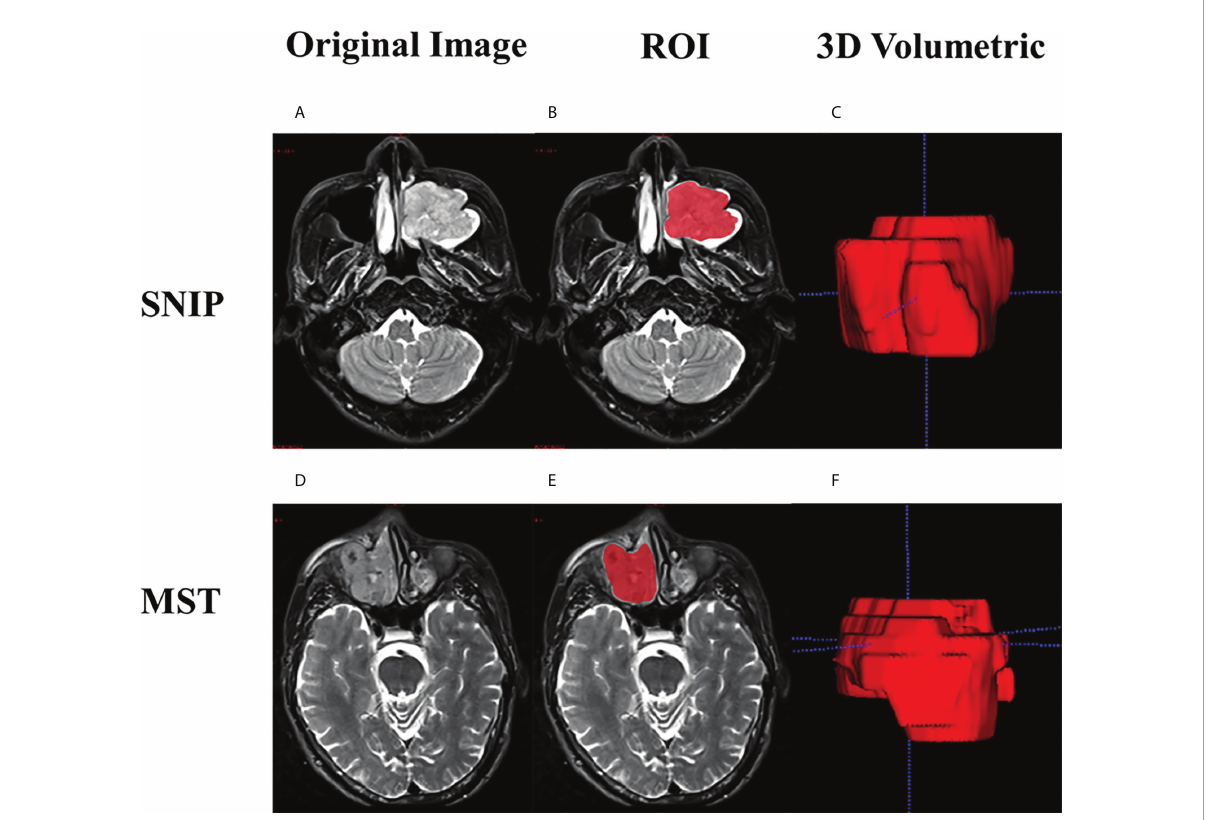
FIGURE 3 Examples of manual ROI segmentation. Case 1: a 47-year-old man with SNIP in the left maxillary sinus, (A) Original image; (B) The ROI contour formed by manual segmentation; (C) 3D volumetric reconstruction. Case 2: a 60-year-old man with squamous cell carcinoma in the right maxillary sinus, (D) Original image; (E) The ROI contour formed by manual segmentation; (F) 3D volumetric reconstruction. SNIP, sinonasal inverted papilloma; MST, malignant sinonasal tumor; ROI, region of interest; 3D,